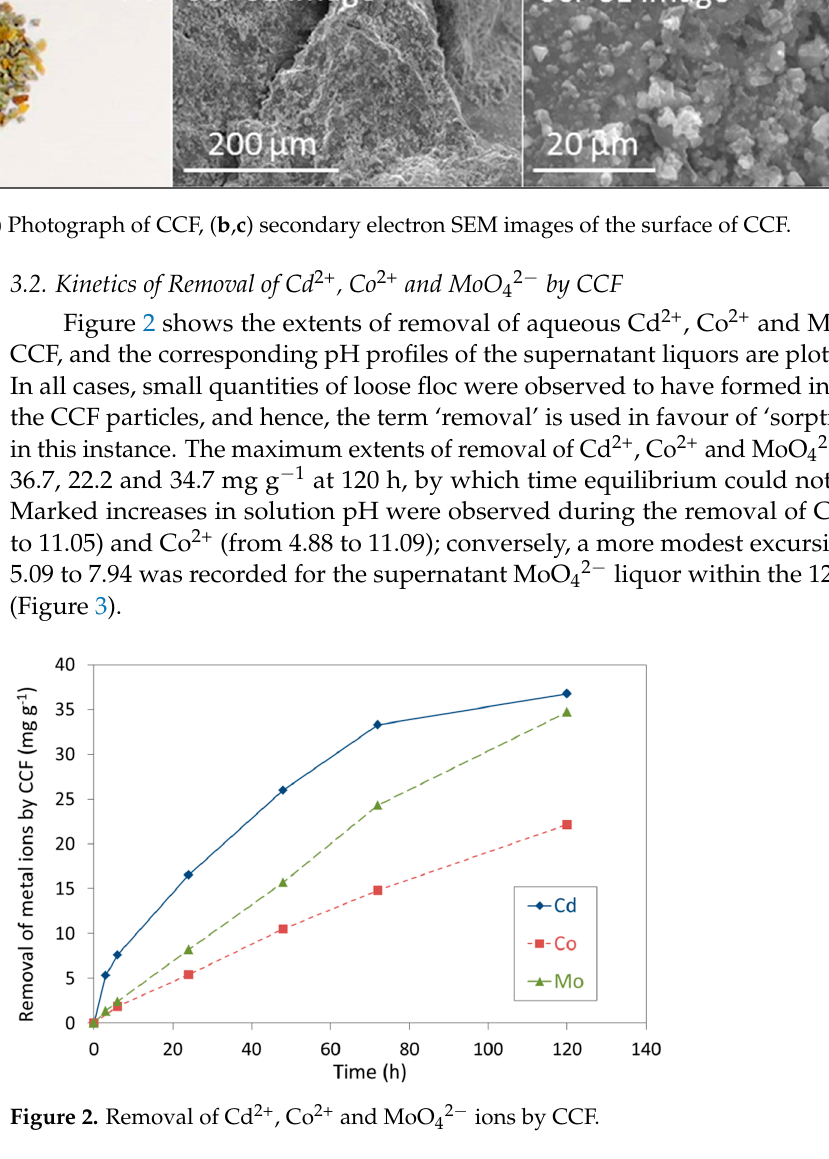
Figure 1. ( a ) Photograph of CCF, ( b,c ) secondary electron SEM images of the surface of CCF.